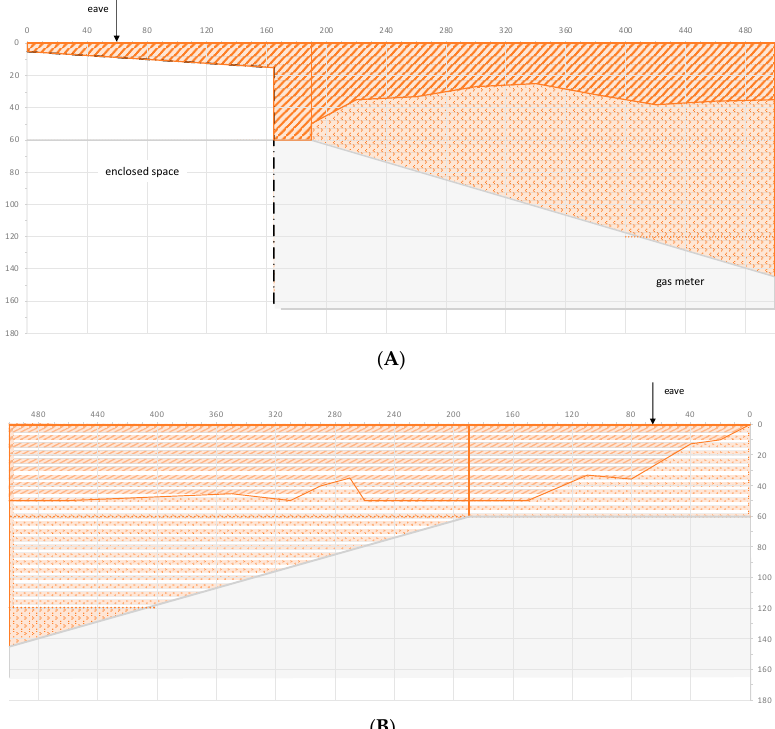
Figure 16. Schematic representation of the observed decay of wall 3: ( A ) eastern face; ( B ) western face. For the legend, see Figure 13.